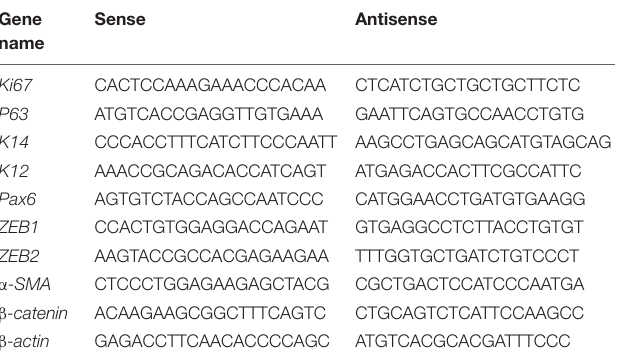
TABLE 1 | Primer sequences for qRT-PCR of indicated gene